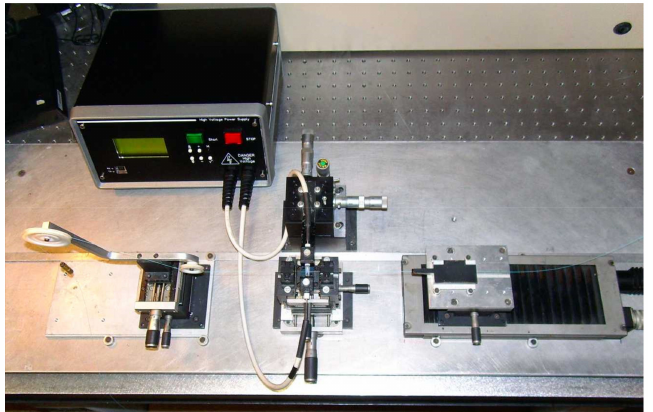
Figure 6. Experimental setup for LPFGs fabrication in the dispersion turning points. Reprinted with permission from ref. [98]. © 2016